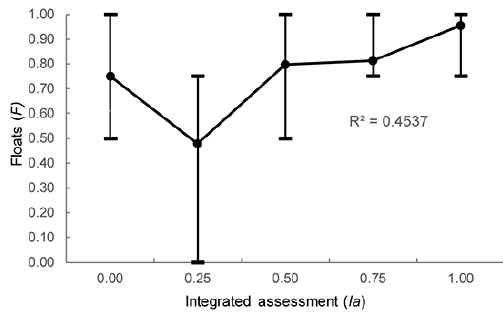
Figure 6. The correlation between I a and F .